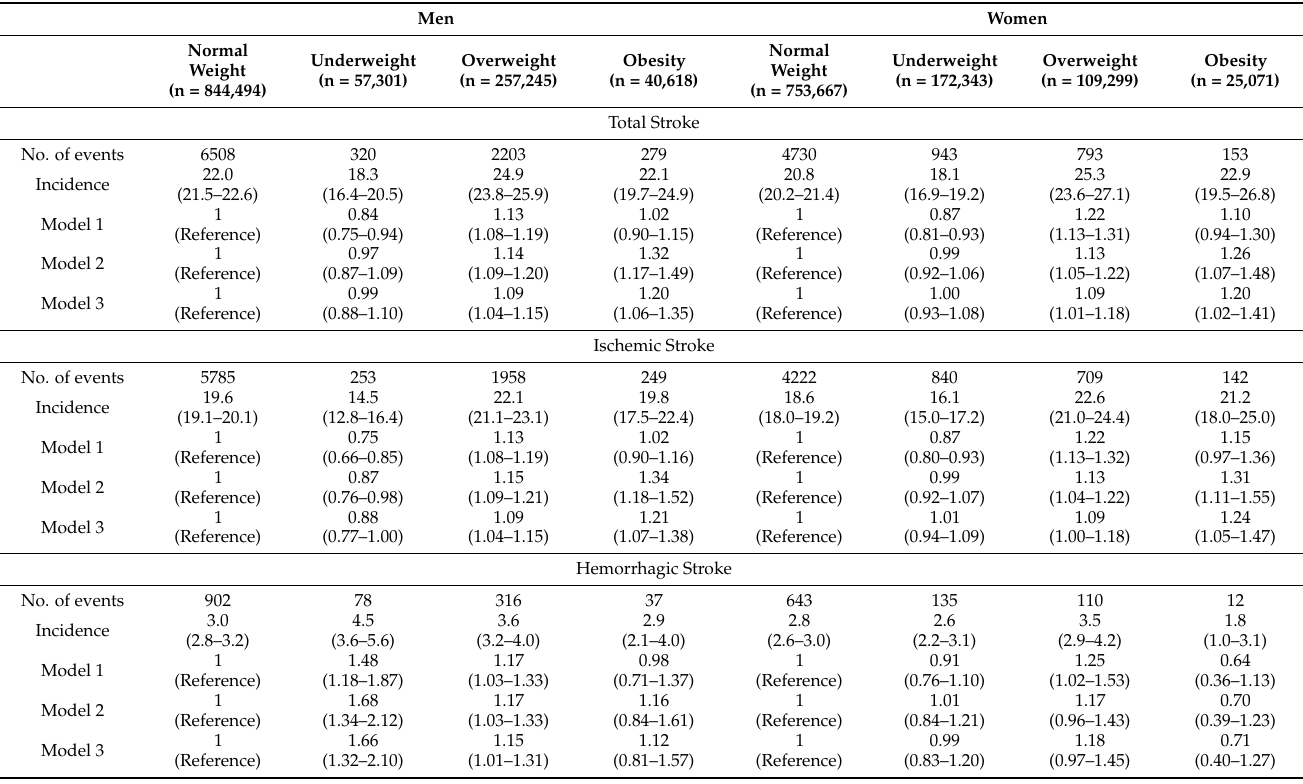
Table 4. Association between Body Mass Index Category and Stroke Events Stratified by Sex in Non-Hypertensive